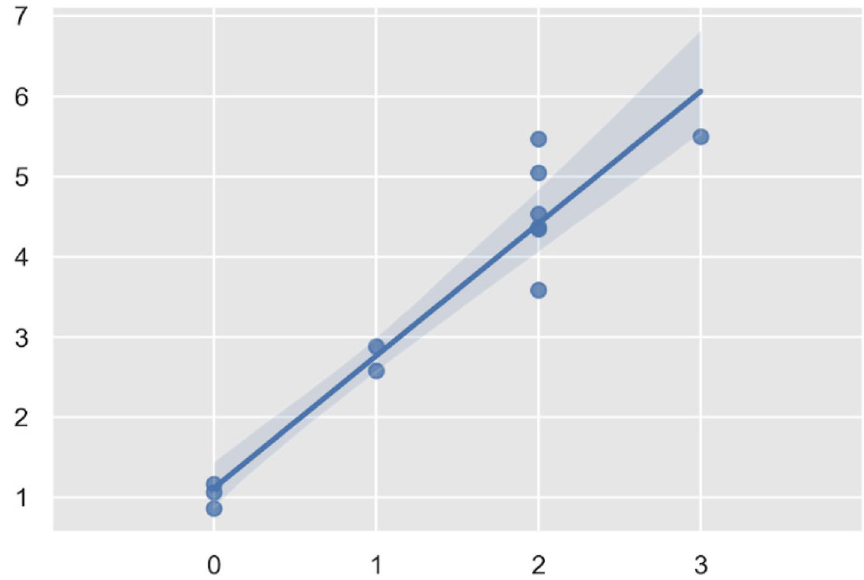
Fig. 4 Forest plot of the mean values of tibial acceleration in Y axis according to the IKDC grade of PS in X